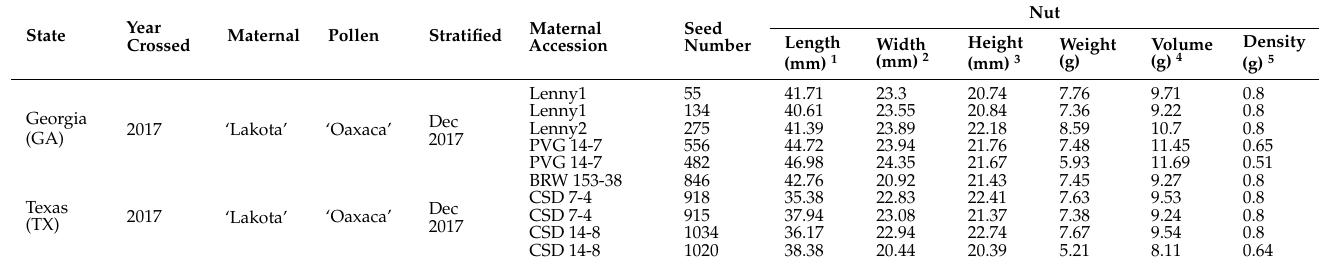
Table 1. ‘Lakota’ × ‘Oaxaca’ seed information and measurements. The seeds used in this study obtained from the controlled ‘Lakota’ × ‘Oaxaca’ crosses were individually